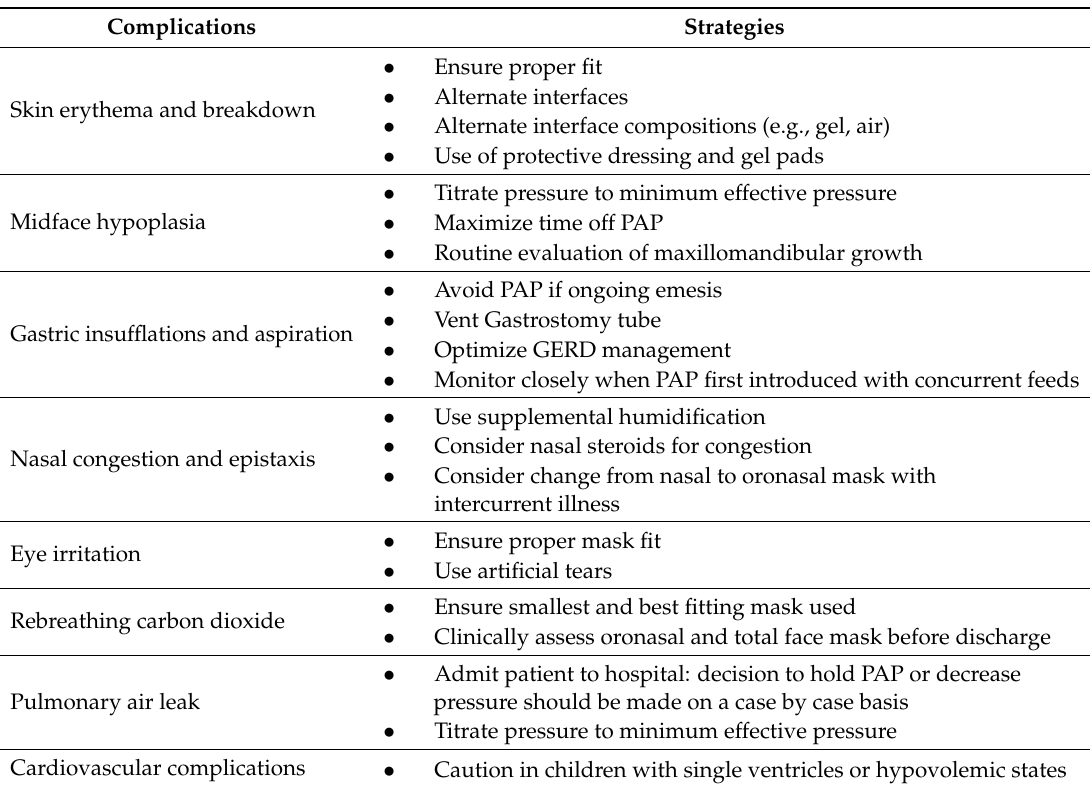
Table 5. PAP complications and corresponding